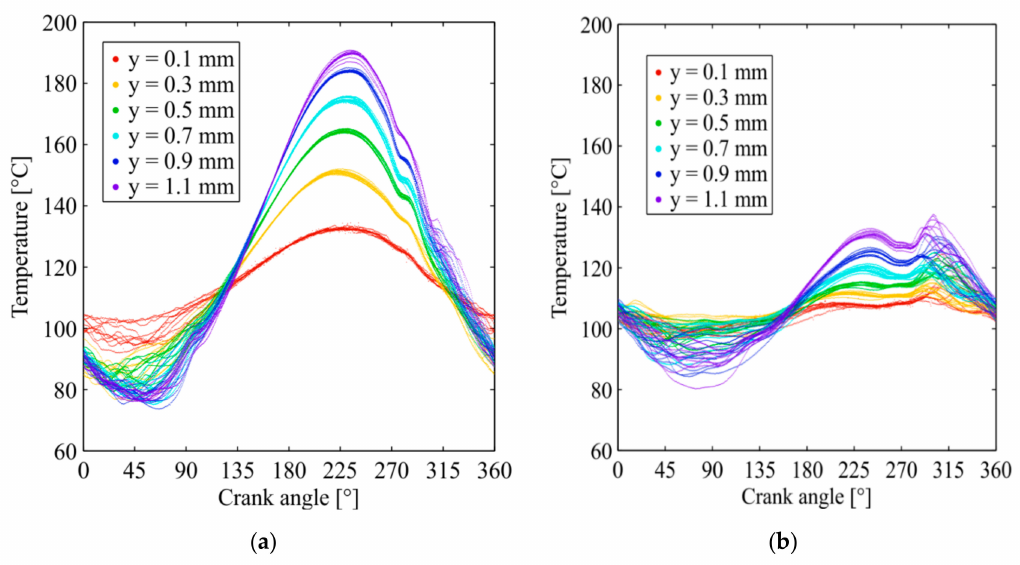
Figure 7. Gas temperatures in Vuilleumier mode close to the seal (probe d) at nominal conditions except p = 20 bar: ( a ) old seal design [32]; ( b ) new seal